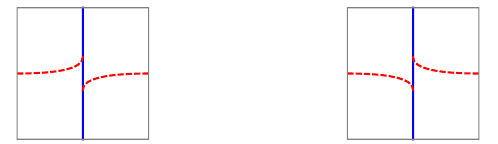
Figure 35 . The action of